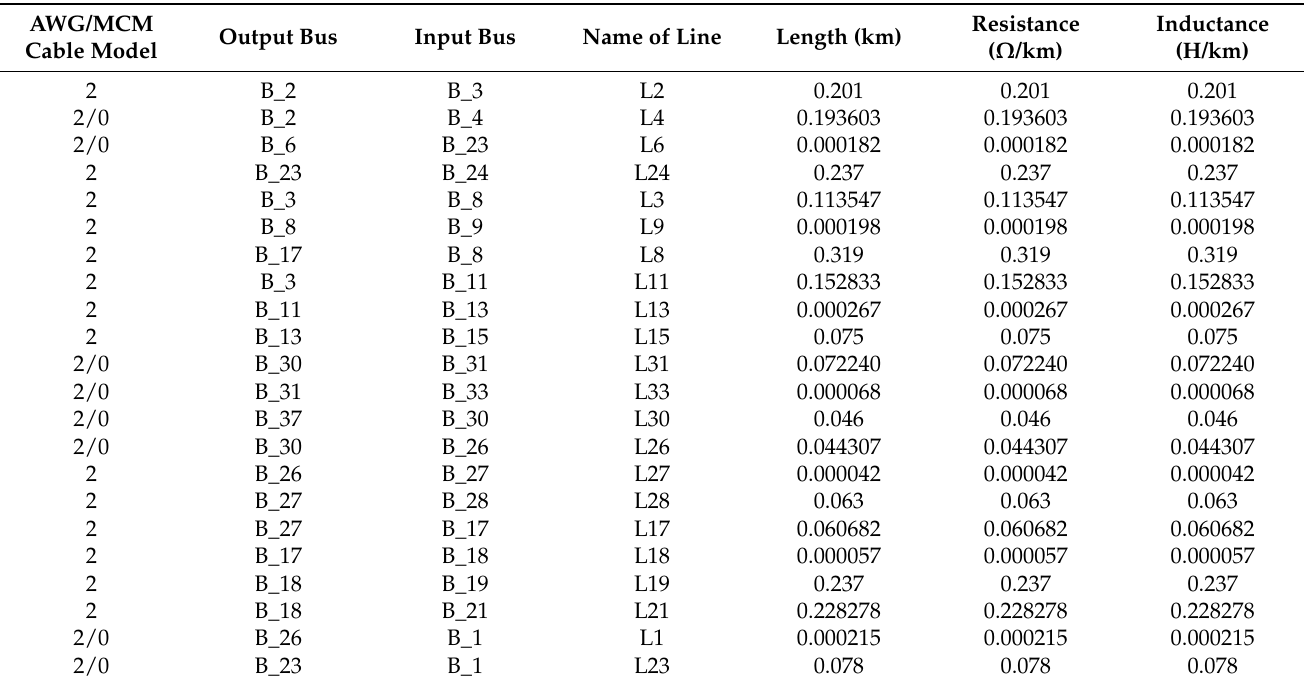
Table 4. Data from the interconnection lines [31],